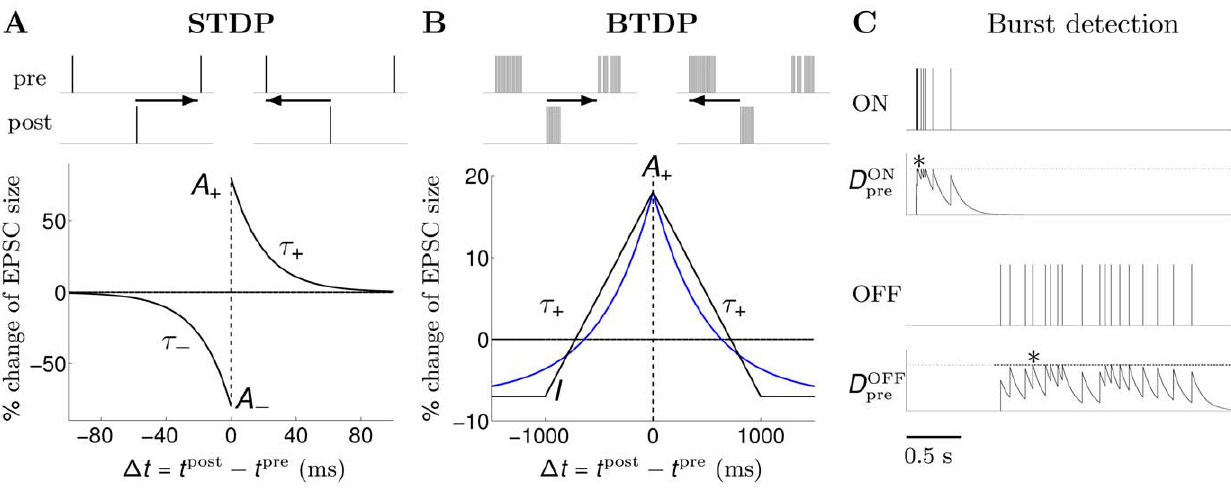
Figure 2. STDP versus BTDP and burst detection. (A) STDP modifies synaptic strength based on the timing, D t ~ t post { t pre (indicated by horizontal arrows), and firing order of pairs of pre- and postsynaptic spikes [10]. Synaptic change occurs in a time window on the order of tens of milliseconds determined by t z and t { , with maximum change at D t & 0 given by A z and A { (%) in EPSC (evoked postsynaptic current) size. (B) BTDP governs synaptic change based on the timing (but not order) of pre- and postsynaptic bursts over a second-long time window, t z [16]. We fit the blue symmetric exponential curve to the linear experimental fit, where A z and I denote the amounts of maximum synaptic potentiation and depression in % of EPSC size, respectively. (C) We detected ON (top) and OFF (bottom) bursts by accumulating burst detection variables D ON D OFF . At the arrival of a spike, D increases by 1, and otherwise decays exponentially with a time constant 100 ms. A burst was detected once D pre reached a fixed threshold (here 1.5) denoted with an asterisk; D was not allowed to exceed the threshold value. The location of the asterisk (instead of the start time of the burst) was used to evaluate the burst latency for synaptic change. Parameters for STDP and BTDP are listed in Table 3. Figure modified from [68] with permission from the HFSP